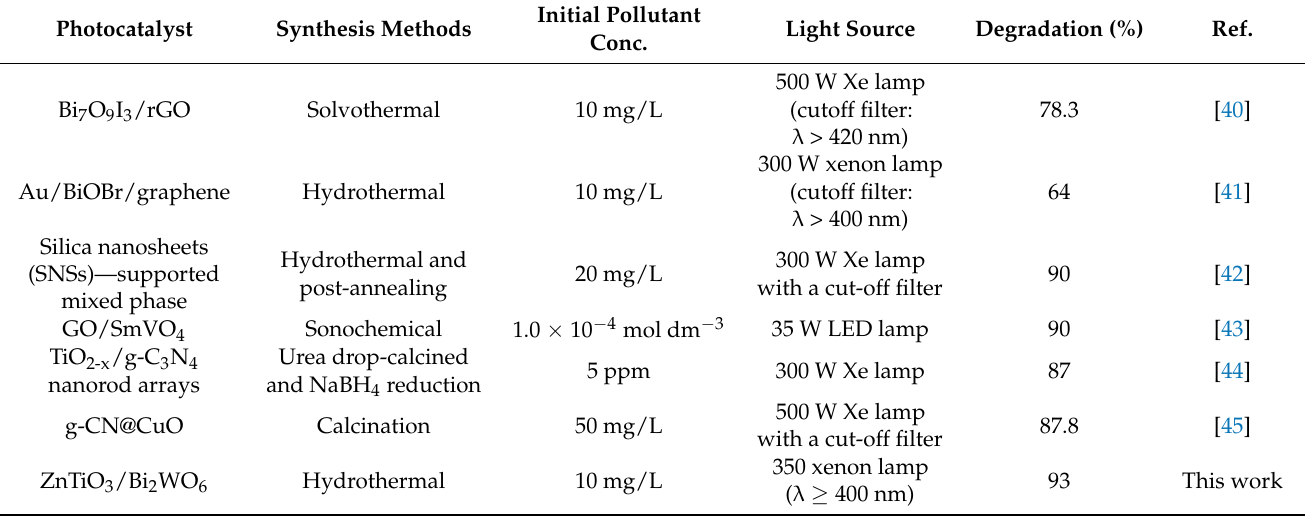
Table 3. Photocatalytic degradation of phenol wastewater in the presence of semiconductor